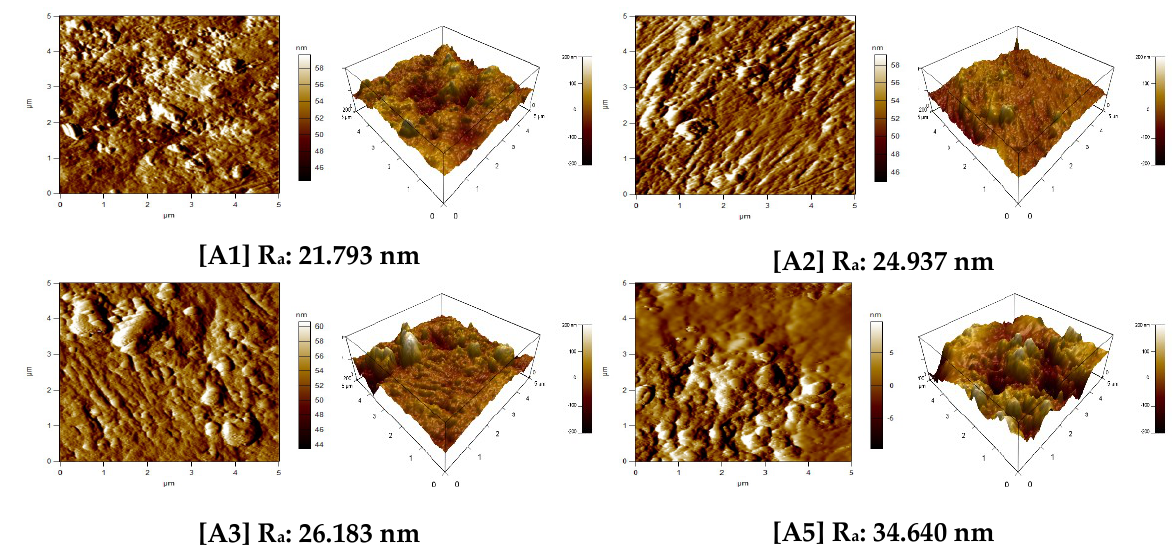
Figure 6. 2D and 3D surface images of ( A1 ) pure Al, ( A2 ) Al/5SiC, ( A3 ) Al/5SiC/3TiO 2 , and ( A5 ) Al/5SiC/9TiO 2 hybrid nanocomposites.